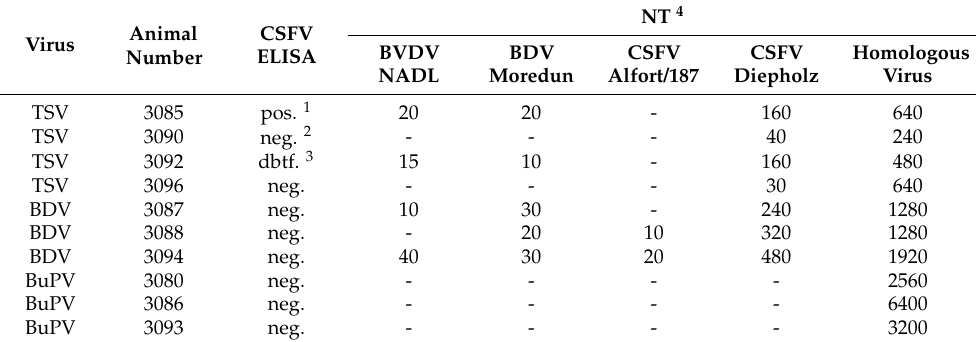
Table 2. Cross-reactivity of sera taken from the individual animals at the end of the experiment. The samples were analyzed by a CSFV E2 antibody ELISA and by NTs against the indicated